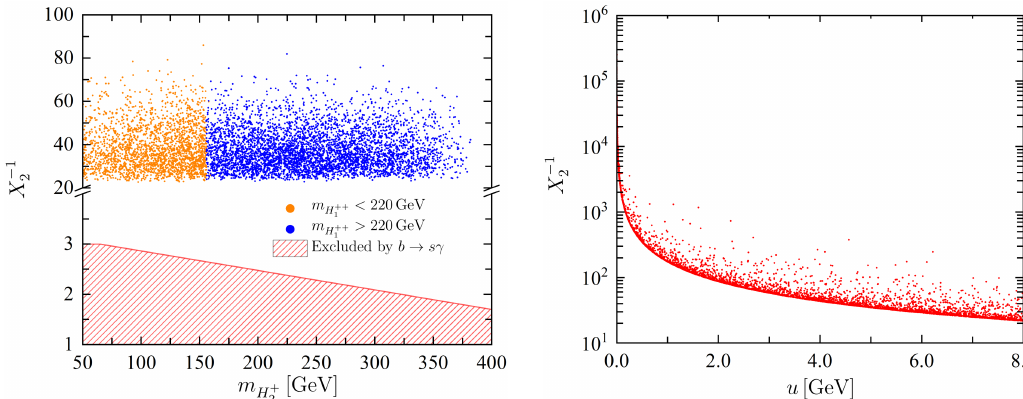
) plane — see eqs. (4.5) and (4.6). The hatched , m 2 H + 2 is above (below) H ++ 1